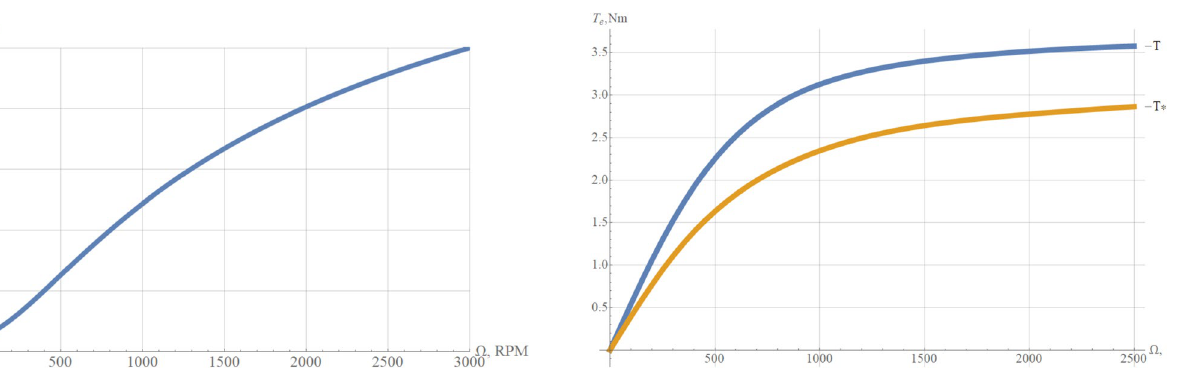
Fig. 5 Coupling output